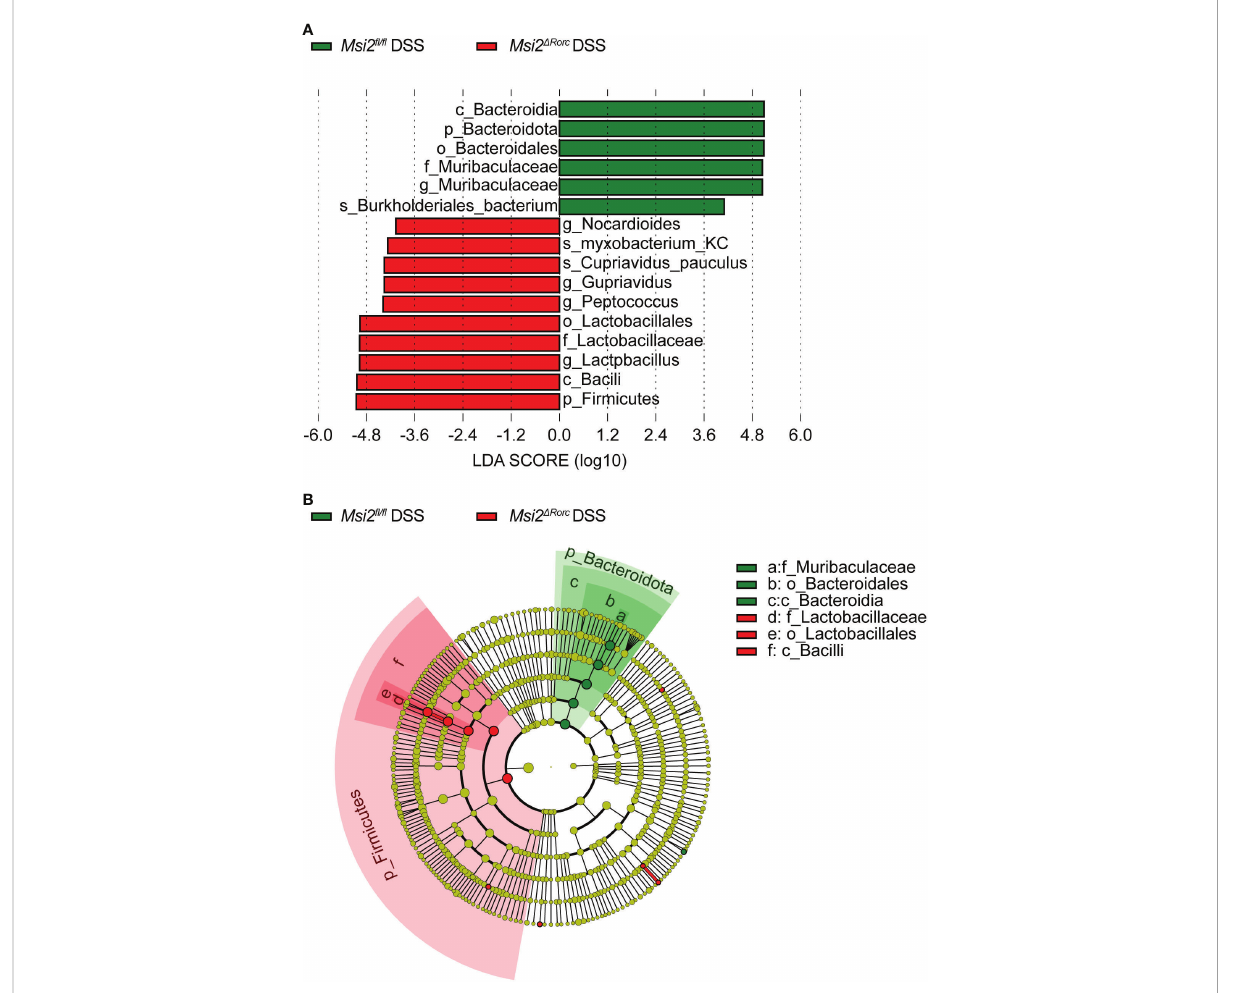
FIGURE 8 LEfSe analysis indicates the biomarkers of intestinal microbiota between the two groups. (A) Taxa with LDA scores greater than 4 according to the comparison of the Msi2 fl / fl DSS group and the Msi2 D Rorc DSS group. Taxa are represented as p (phylum), c (class), o (order), f (family), g (genus) and s (species). (B) Taxonomic cladograms of the Msi2 fl / fl DSS group and the Msi2 D Rorc DSS group. The green and red dots are proportional to the degree of enrichment of certain taxa between the two comparative groups